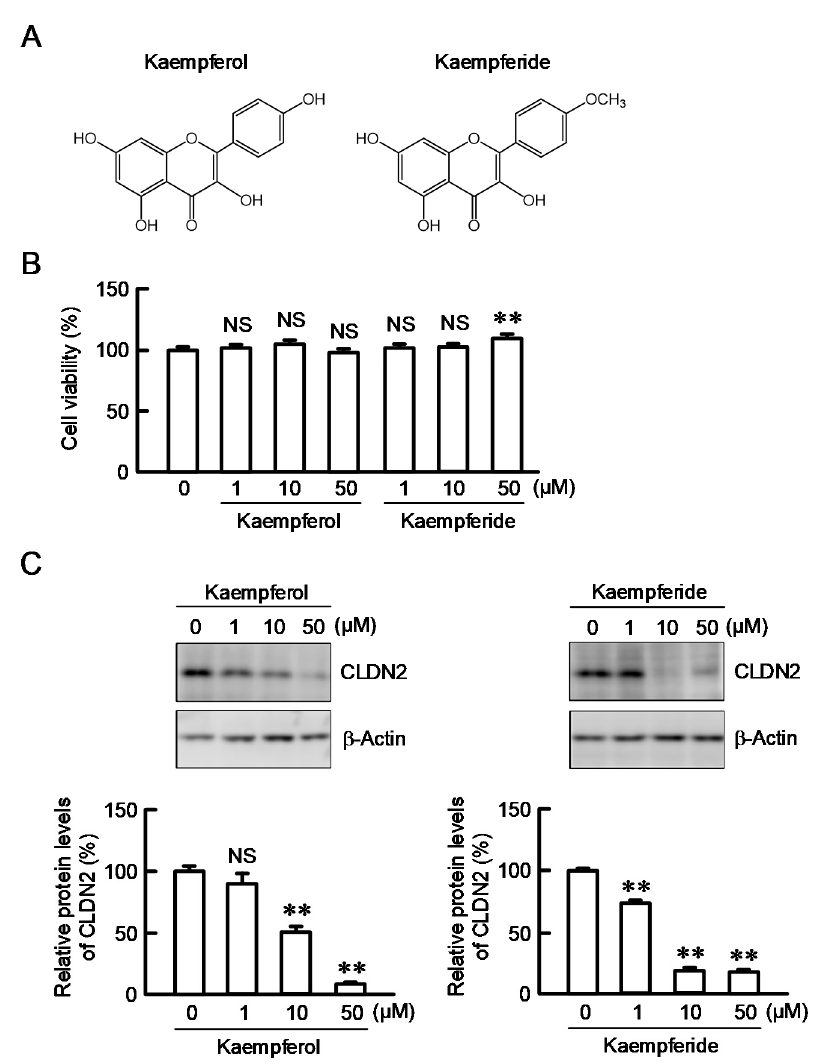
Figure 4. Decrease in CLDN2 expression by kaempferol and kaempferide. ( A ) Structures of kaempferol and kaempferide. ( B and C ) Cells were incubated with 0, 1, 10, and 50 μ M kaempferol or kaempferide for 24 h. Cell viability was assessed by the WST-1 assay and represented as a percentage relative to 0 μ M. The protein level of CLDN2 was examined by Western blotting and represented as a percentage relative to 0 μ M. β -Actin was used as an internal control. n = 3–8. ** p < 0.01 and NS p > 0.05 compared with 0 μ M (one-way analysis). Viability (F 6,22 = 5.19, p = 0.00184), protein in kaempferol (F 3,8 = 52.71, p < 0.0001), and protein in kaempferide (F 3,8 = 490.69, p < 0.0001).